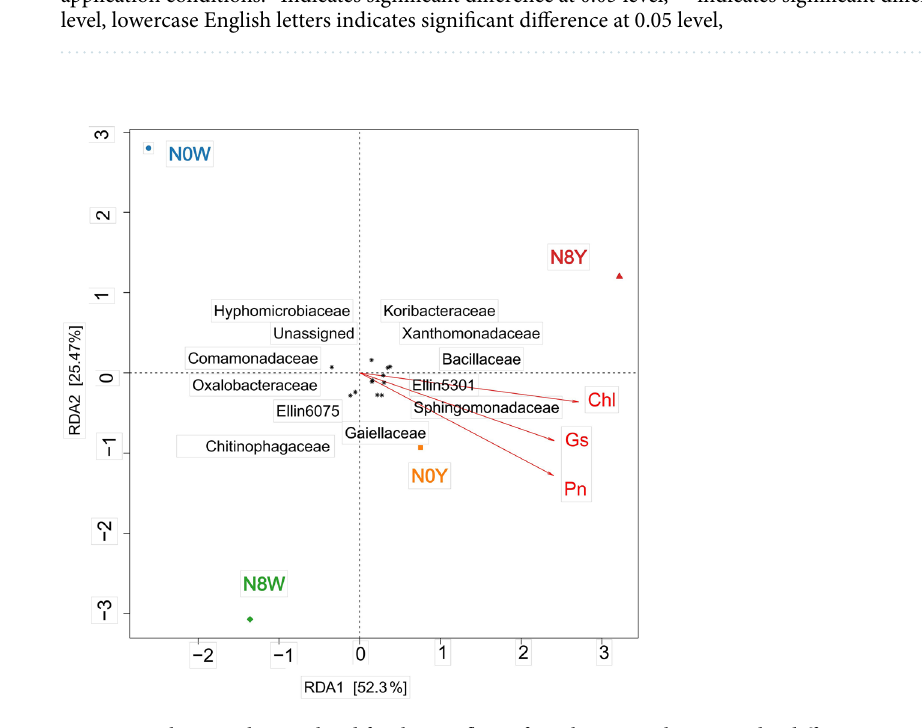
Figure 6. Photosynthesis-related focal microflora of sorghum populations under different nitrogen application